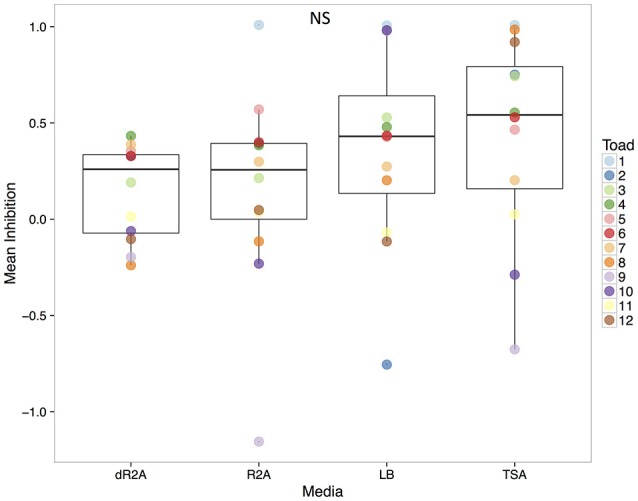
Mean inhibition estimates for each plated community by culture media. Estimates are color-coded at the toad level (individual #). Boxplots represent the median, upper and lower quartile, and maximum and minimum values. Inhibition estimates with negatives values suggest facilitation of Bd growth, while positive values suggest inhibition, with estimates = 1 representing a complete inhibition of Bd growth.